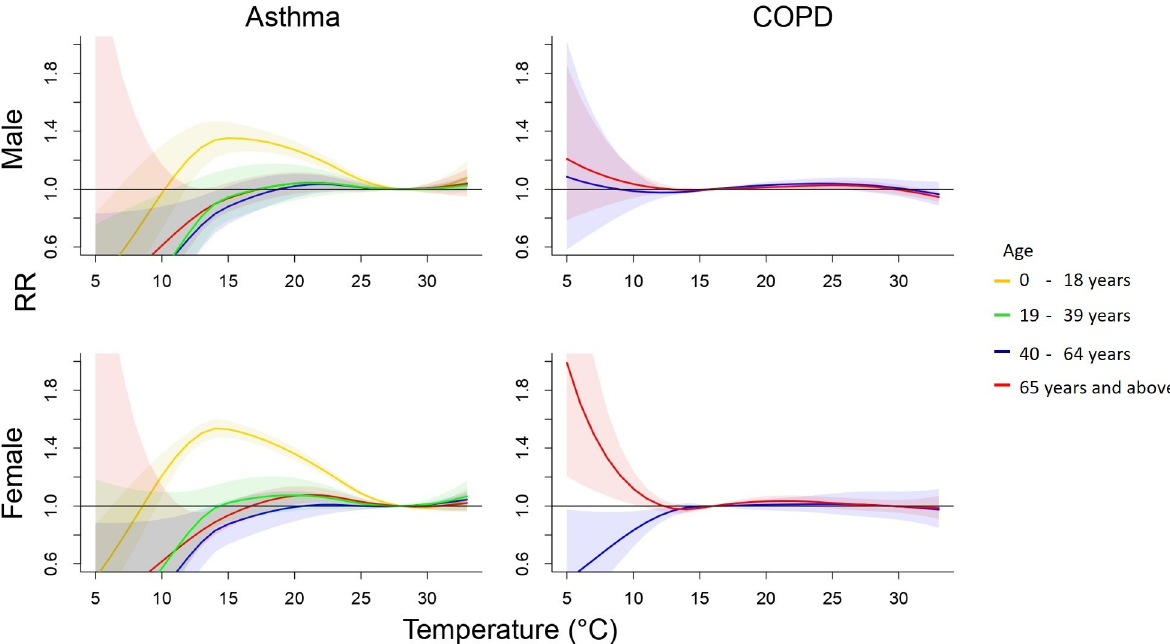
Fig 4. Cumulative 8-day (lag 0–7) relative risk (95% confidence interval) of sex-age specific outpatient visits for asthma and COPD associated with daily average temperature.